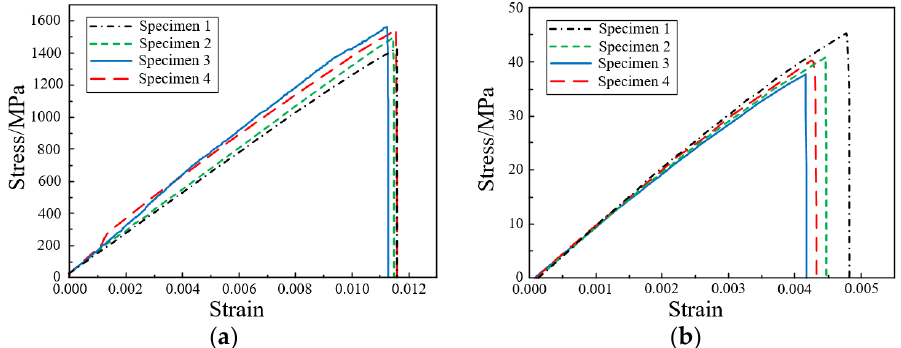
Figure 4. Uniaxial tensile stress-strain curve: ( a ) Specimen at 0° layer; ( b ) Specimen at 90° layer.